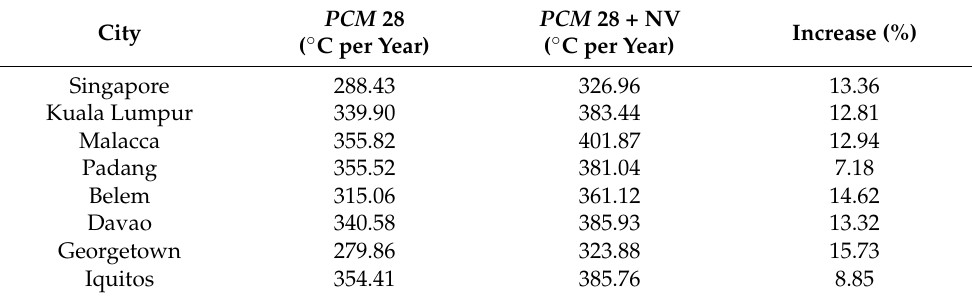
Table 4. TTD values for all the cities for the PCM 28 and PCM 28 + NV